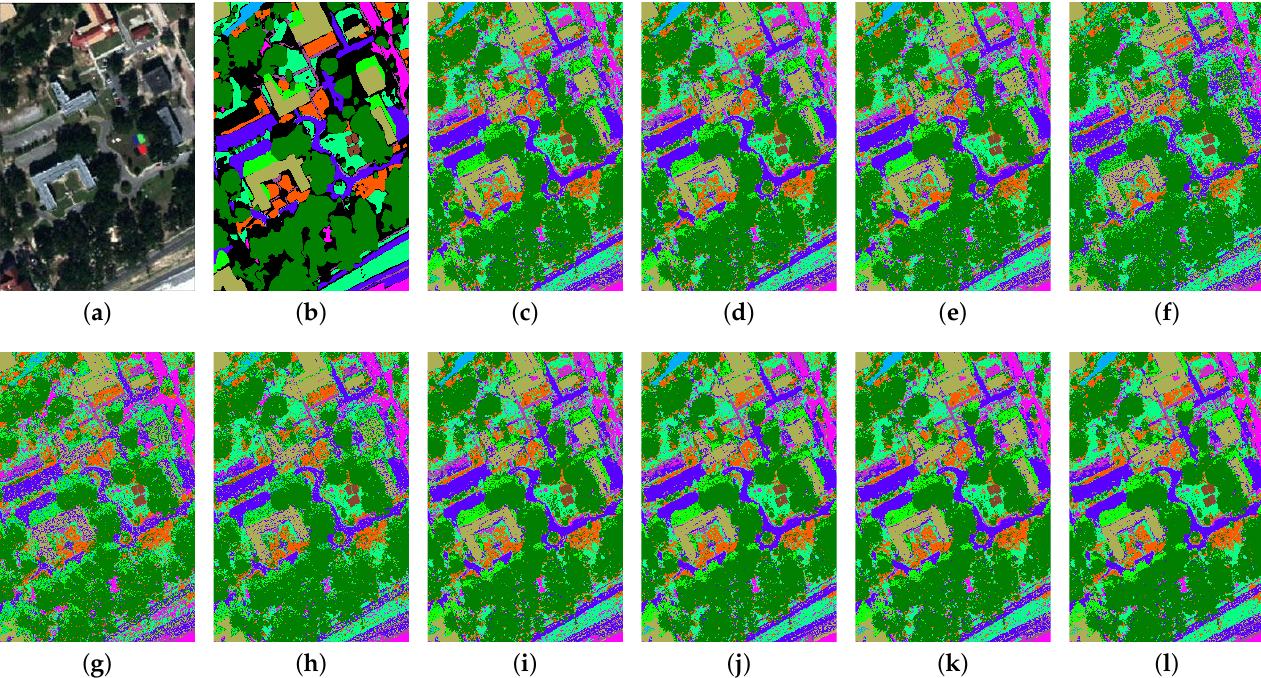
Figure 11. Classification maps for the whole scene on the MUUFL data set. ( a ) False color image; ( b ) ground truth; ( c ) RAW; ( d ) PCA; ( e ) LPP; ( f ) LDA; ( g ) LFDA; ( h ) LGSFA; ( i ) SGDA; ( j ) LGDA; ( k ) CGDA; ( l )